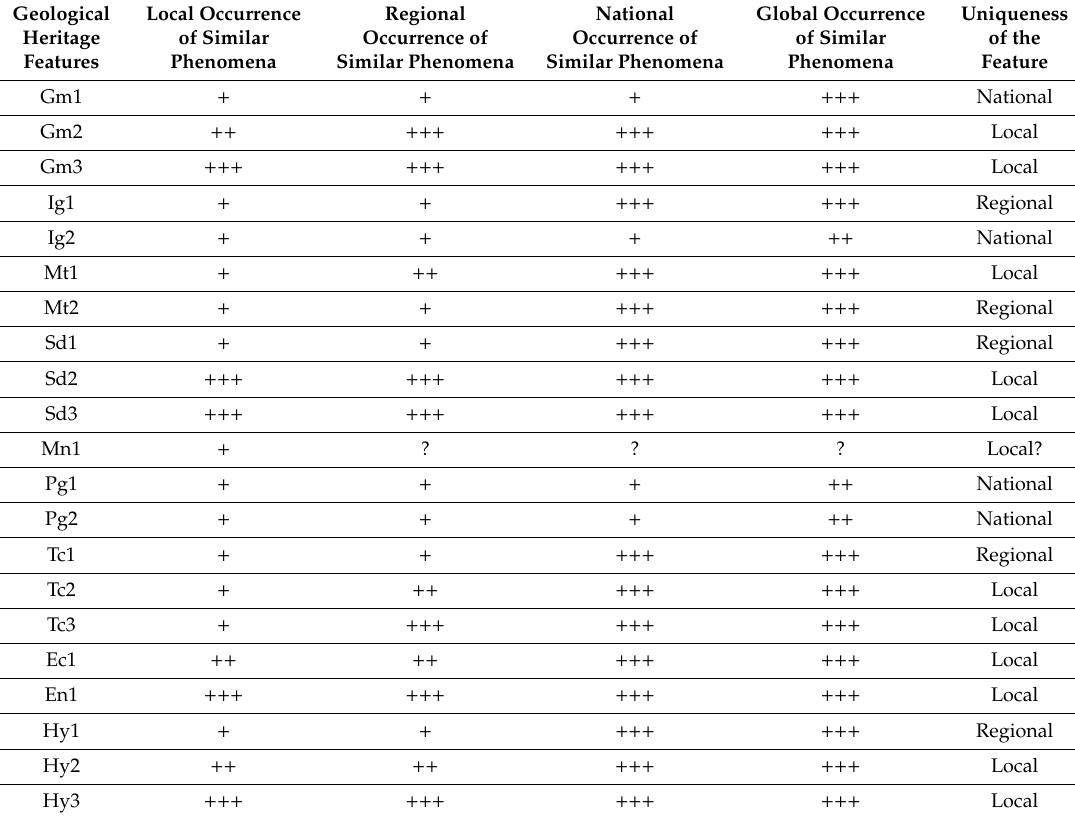
Table 1. Uniqueness of the geological features of the Granite Gorge